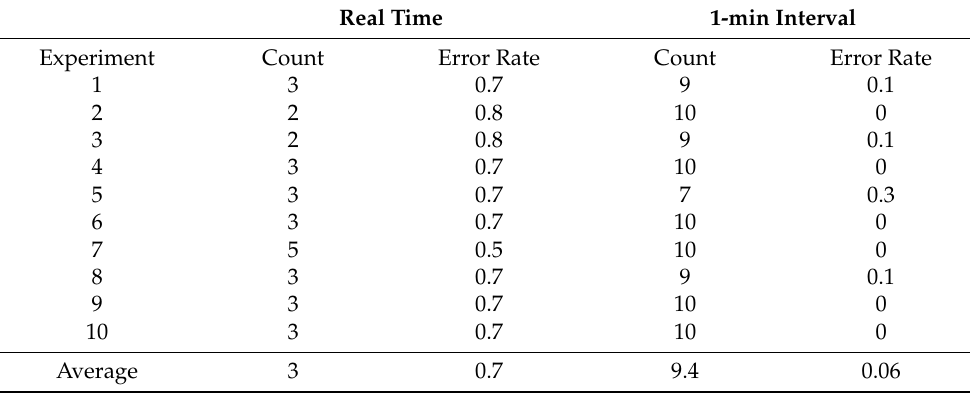
Table 3. Test results of sensor